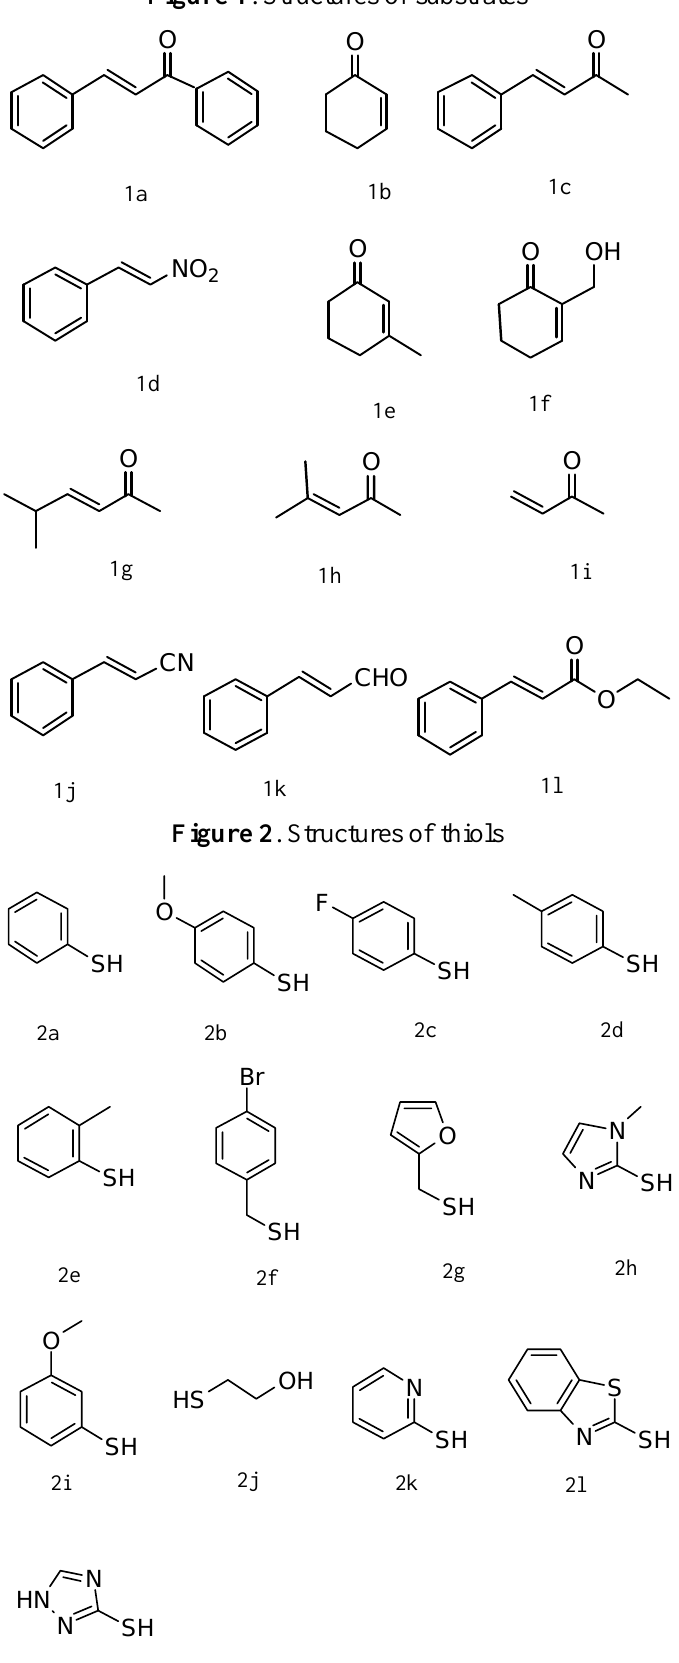
Figure 2 . Structures of